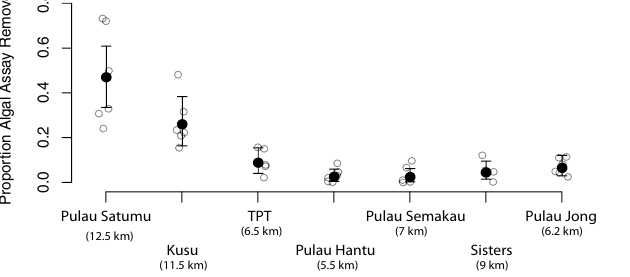
Figure 3. Proportion of algal assay mass removed on each reef ( n = 5–6). Raw data (open symbols) and back- transformed model fits (filled symbols ± 95% CI) from linear model of logit-transformed proportion mass removed from each assay. Reefs are ranked by proportion of hard coral cover along the x-axis (decreasing left to right) and distance from the main port presented in parentheses (km).